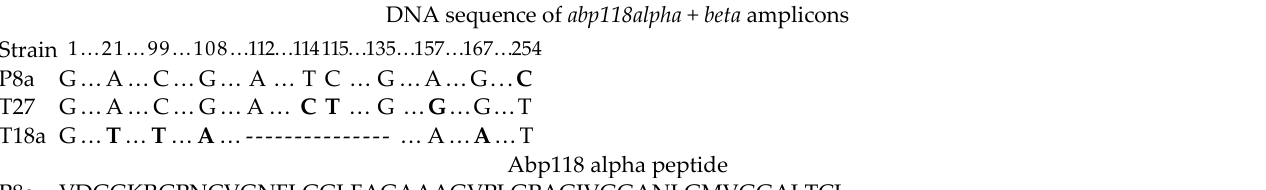
Table A3. Analysis of DNA sequence and putative protein sequences of Abp118 bacteriocin. DNA sequence of abp118alpha + beta amplicons